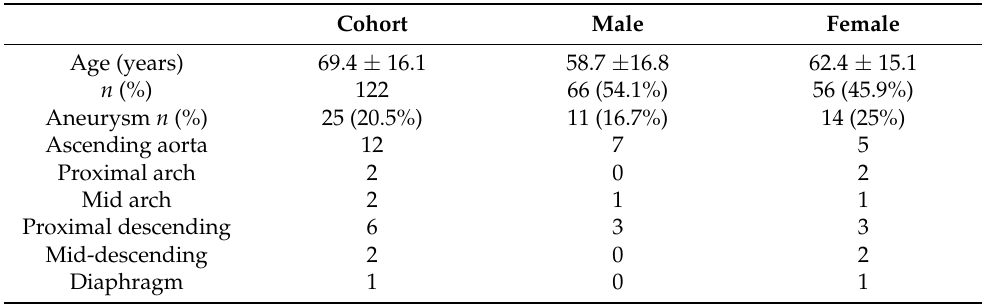
Table 2. Demographic and subject data. The remaining locations of the aorta are not mentioned due to no found